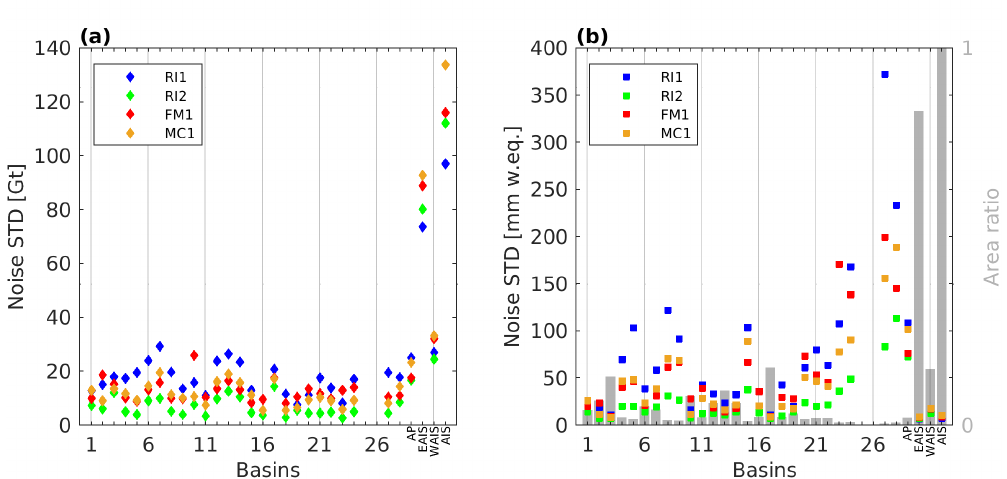
Figure 5. Noise level, given in terms of the scaled standard deviation of the noise time series, for all AIS basins and aggregations, derived from ( a ) the mass change time series and ( b ) the time series of the average surface density change. Grey bars indicate the ratio between the basin areas and the entire AIS